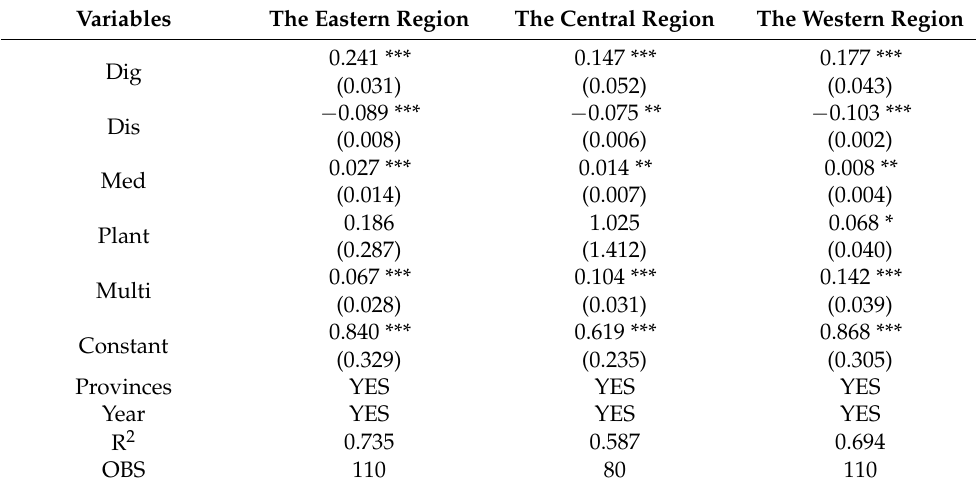
Table 6. Results of regional heterogeneity.